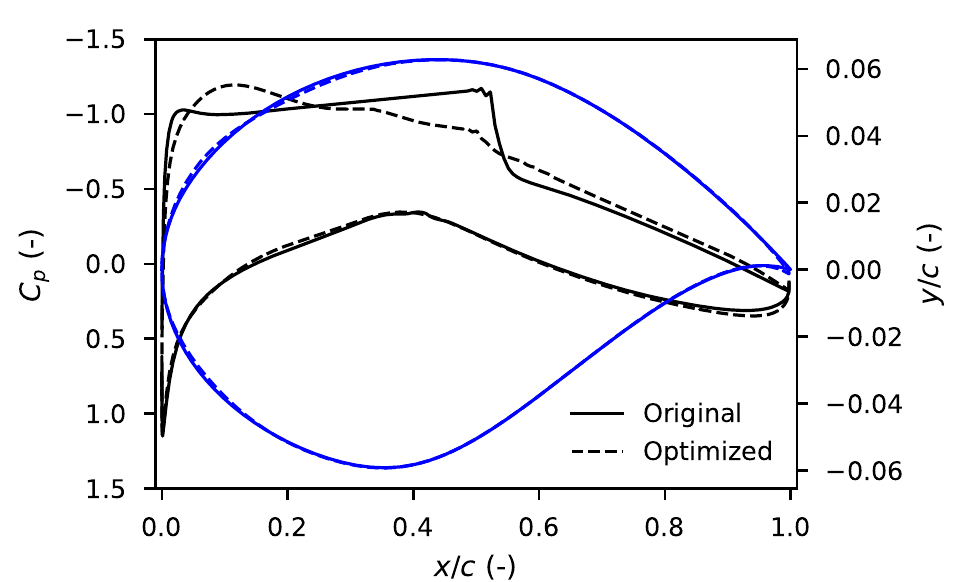
Figure 12. Pressure coefficient comparison for Case 1.